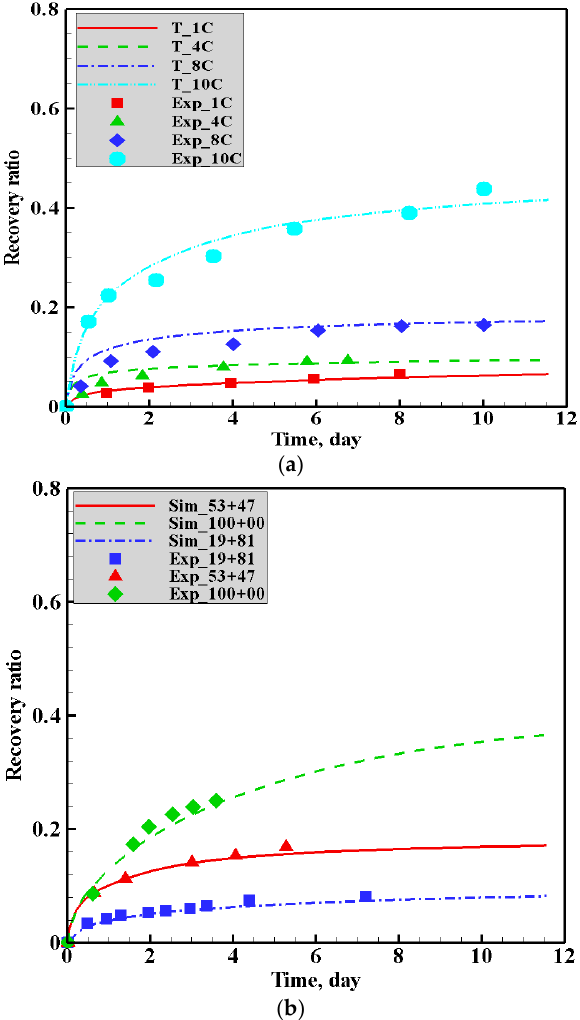
Figure 3. Comparison of simulated with measured recovery ratios of CH 4. ( a ) Recovery ratio of CH 4 at 14.0 MPa with a gas mixture of 53% CO 2 + 47% N 2 ; ( b ) recovery ratio of CH 4 with varying mixtures of CO 2 and N 2 at 1.00 °C.